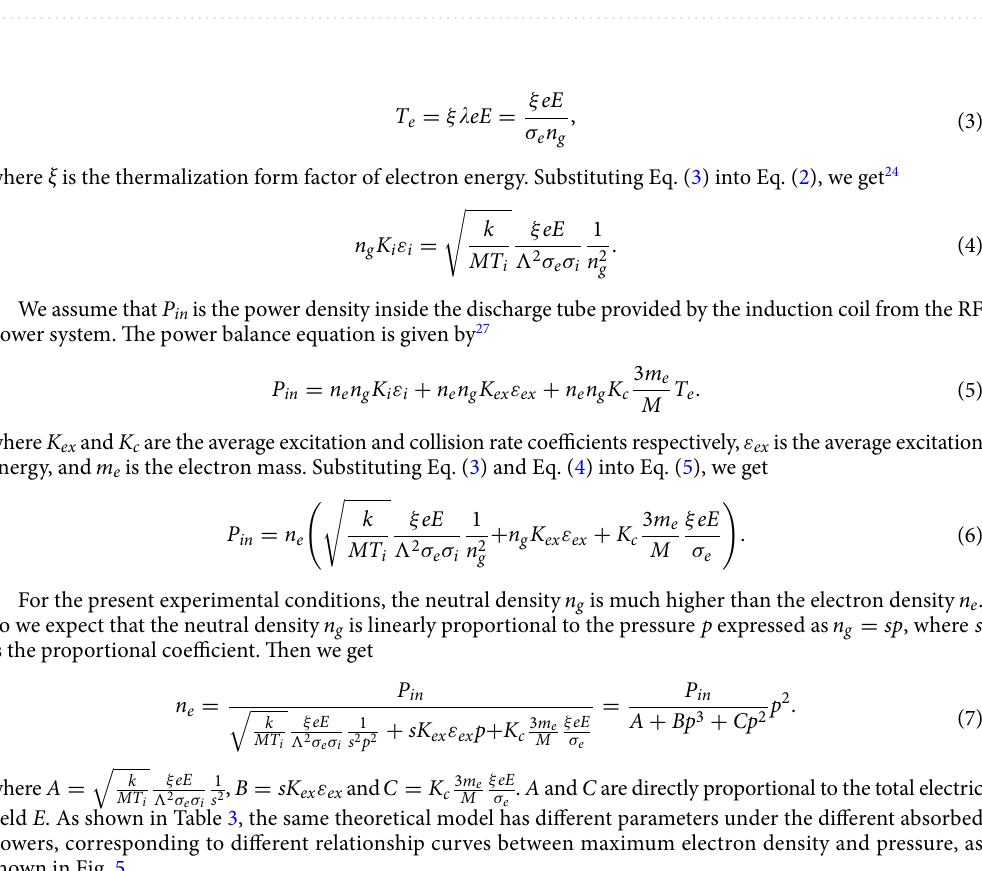
Table 3. Theoretical model parameters for different absorbed